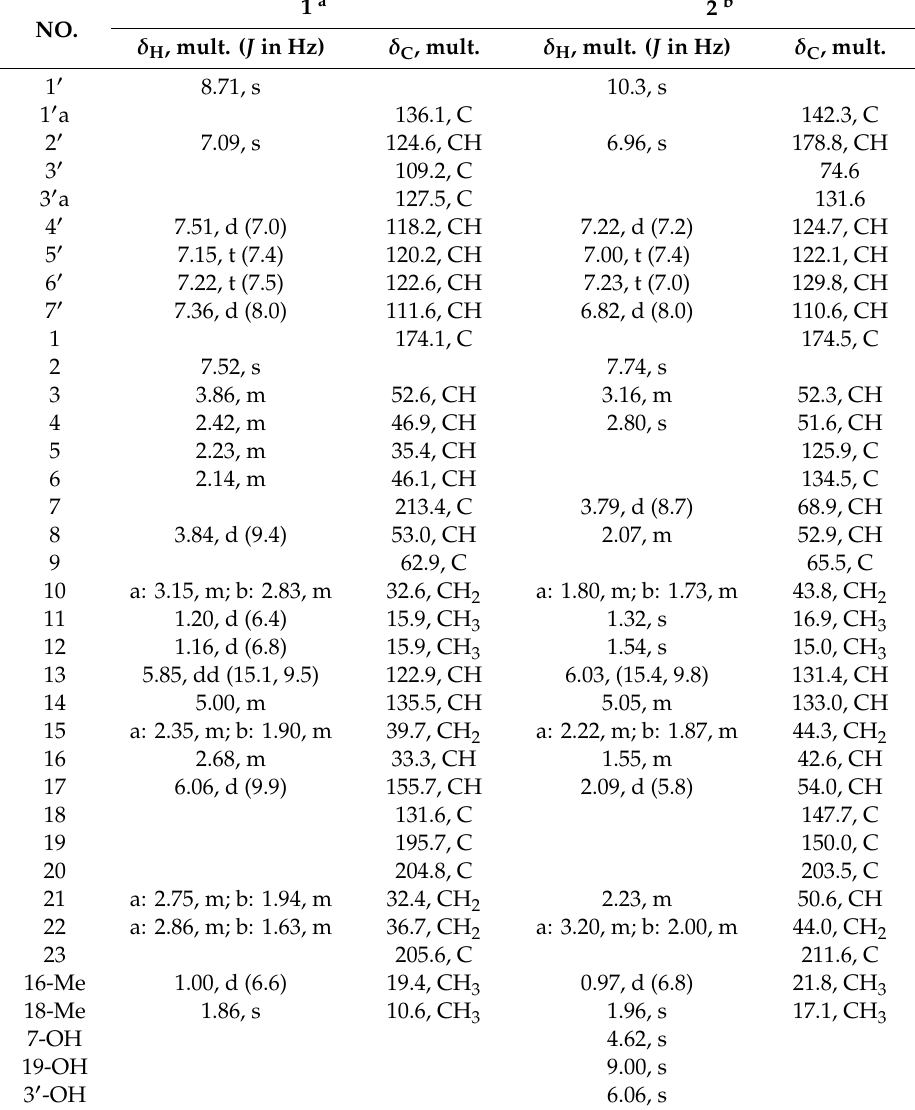
Table 1. 13 C (100 MHz) and 1 H (400 MHz) NMR spectroscopic data for Compounds 1 and 2